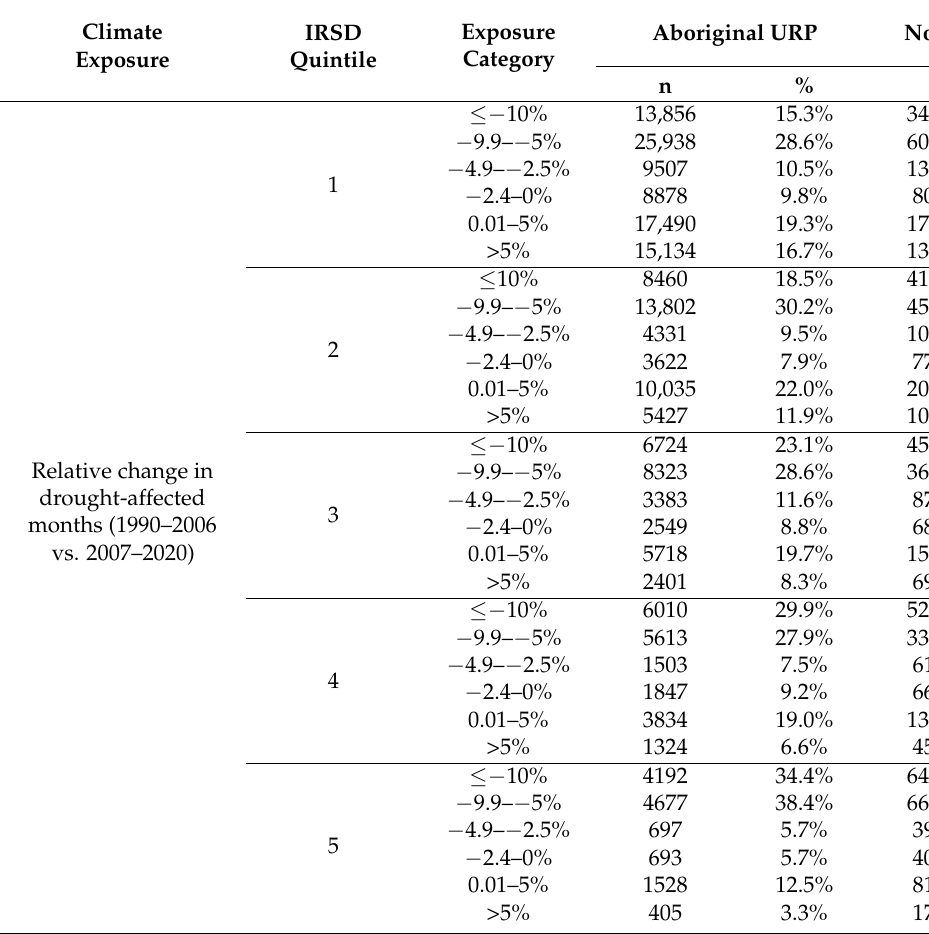
Table A2. Climate exposure estimates by Aboriginal versus non-Aboriginal usual resident populations stratified by the Index of Relative Socioeconomic Disadvantage (IRSD). Small cell counts for either population have been